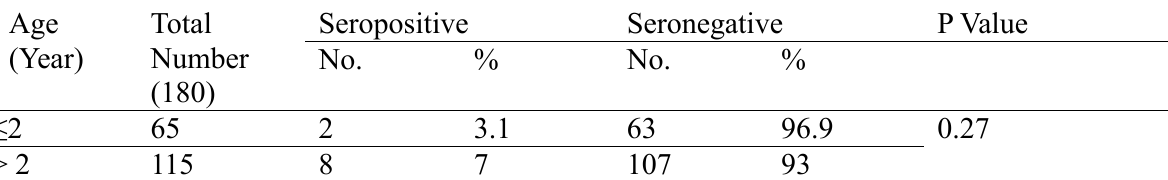
Table 6. The Seropositivity of Anti F. hepatica IgG antibodies in Milk of Sheep by ELISA according to the